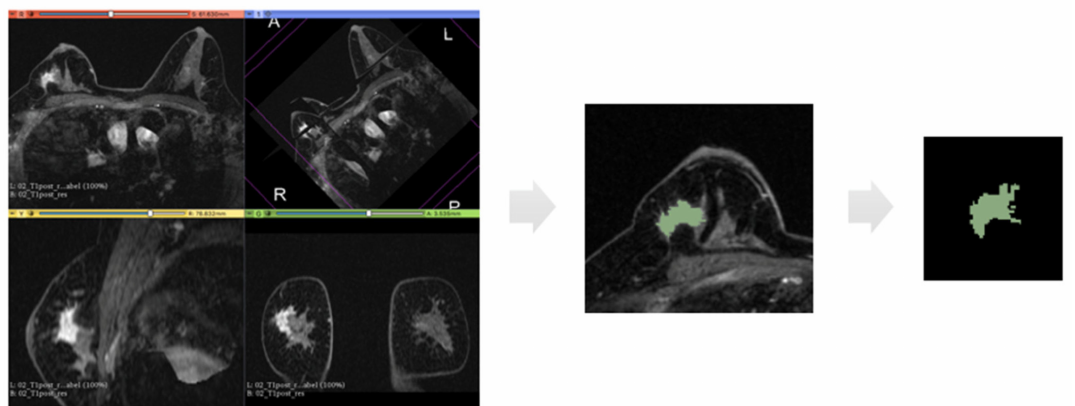
Figure 2. Representation of the extraction of a segmentation mask. From left to right: first panel represents an example of 3D image analysed in our dataset which is the second phase of subtracted post-contrast sequence; then, for each 2D slice, we have the region of interest drawn around the tumour mass and finally the binary mask extracted from this